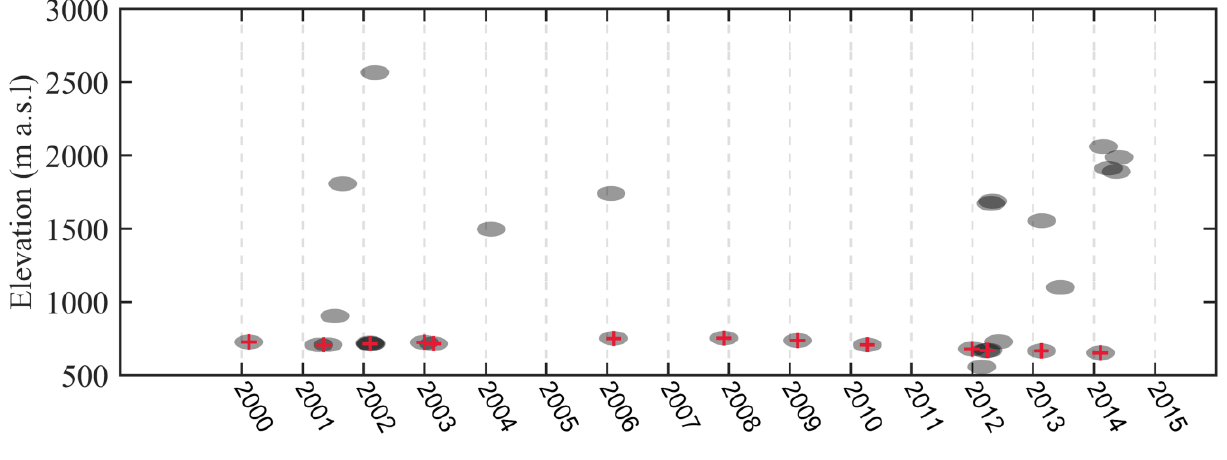
Figure 3. An example of outlier filtering. Data corresponding to point 1 in figure in Section 3.2.3. Gray dots are original DEM elevations. Several extreme high values are likely due to clouds or parallax mismatches. Red crosses are filtered data and grouped by every half year. Years on the horizontal axis refer to 1 January of each